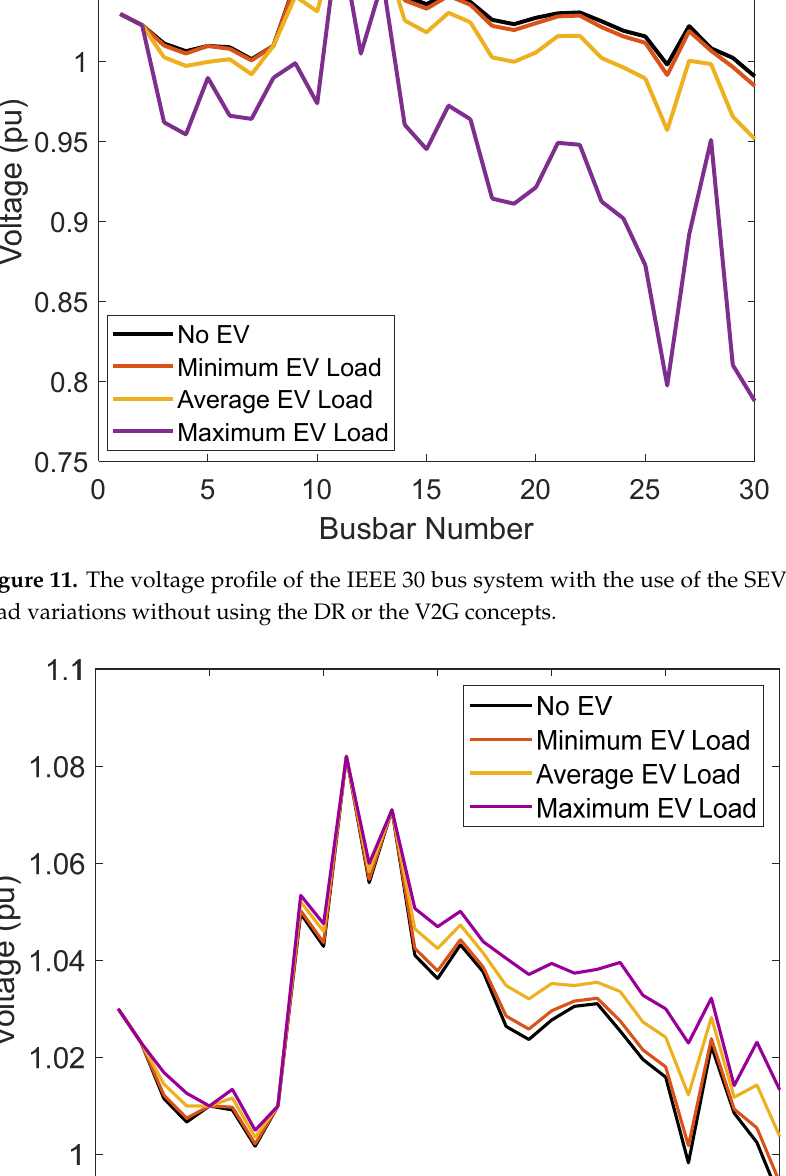
Figure 13. The variation of the transmission line losses with and without the use of DR and V2G.